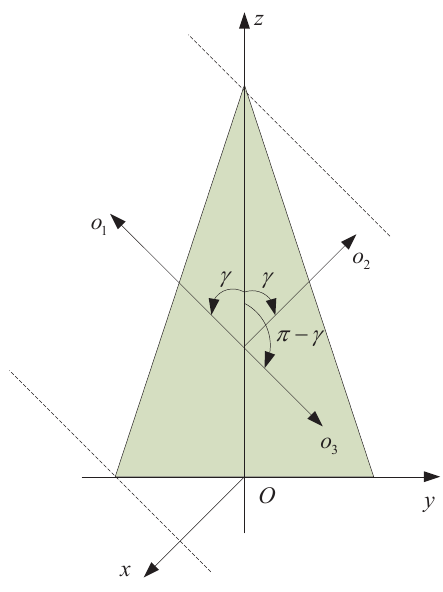
Figure 2. Illustration of the even property of the projection function.